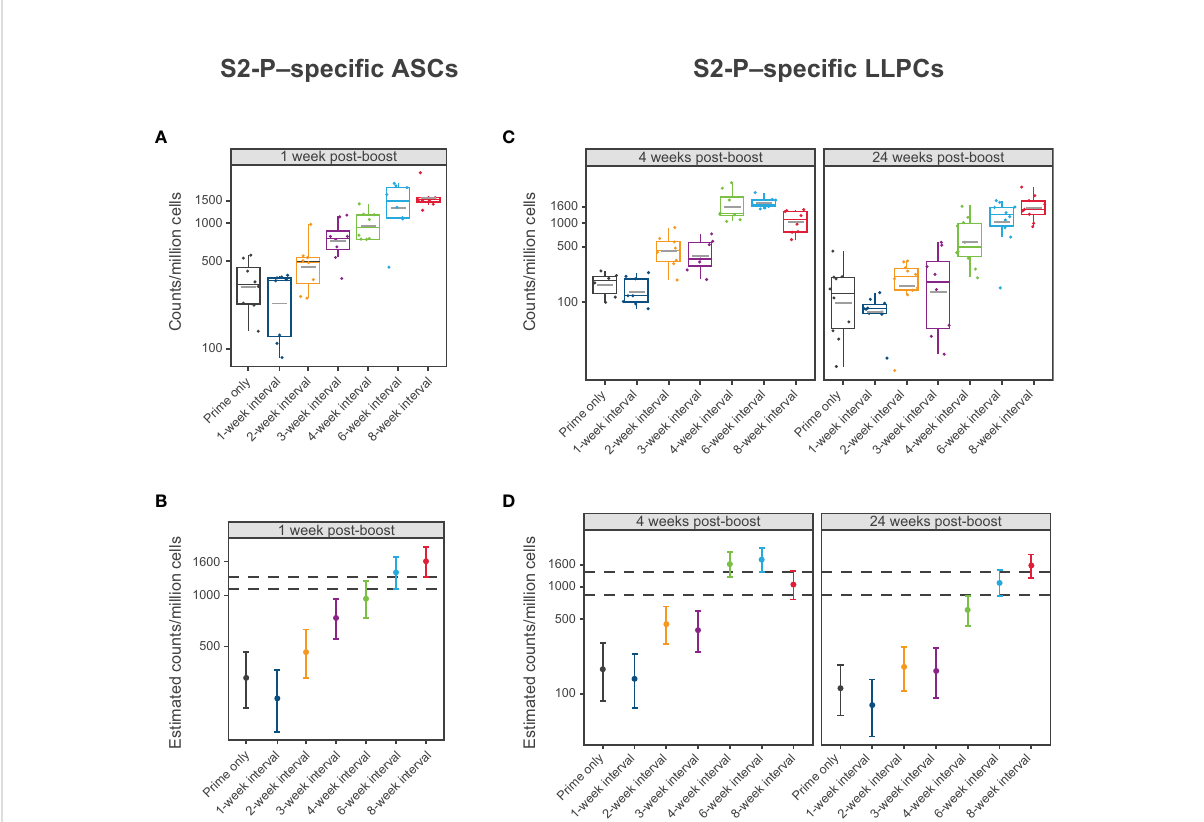
FIGURE 4 S2-P – speci fi c Antibody Secreting Cells and Long-Lived Plasma Cells. (A, B) Levels of S2-P – speci fi c ASCs 1 week following dose 2 of mRNA- 1273 10 µg are presented by dosing intervals (prime only or 1-, 2-, 3-, 4-, 6-, or 8-week intervals between doses). Panel (A) presents individual animal-level data with dots corresponding to individual animals and grey horizontal lines denoting the average within each group. Panel (B) presents the estimated mean and associated 95% CIs based on a statistical model (see Methods), with error bars representing the 95% CI of the estimated mean. (C, D) Levels of S2-P – speci fi c LLPCs 4 weeks and 24 weeks after dose 2 of mRNA-1273 10 µg are presented by dosing intervals (prime only or 1-, 2-, 3-, 4-, 6-, or 8-week intervals between doses). Individual animal-level data (dots corresponding to individual animals and grey horizontal line denoting the average within each group) are shown in panel (C) . Panel (D) presents the corresponding estimated means and associated 95% CIs based on a statistical model (see Methods), with error bars representing the 95% CI of the estimated mean (n=8-10 mice per group). Results of statistical comparisons between groups based on the statistical models are presented in Table S3, Table S4, and Figure S6. ASC, antibody-secreting cell; CI, con fi dence interval; LLPC, long-lived plasma cell; mRNA, messenger